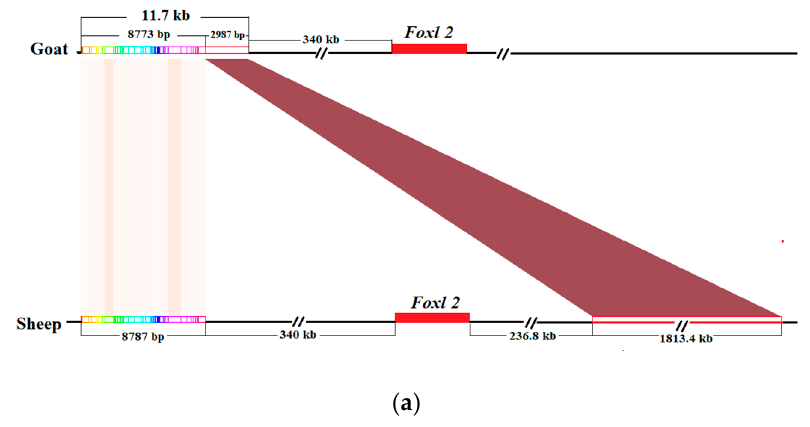
Figure 1. The statistics of mutation type of single nucleotide polymorphisms (SNPs). Note: The proportion of translation (ts) mutations and transversion (tv) mutations meet the 3 to 1 ratio.